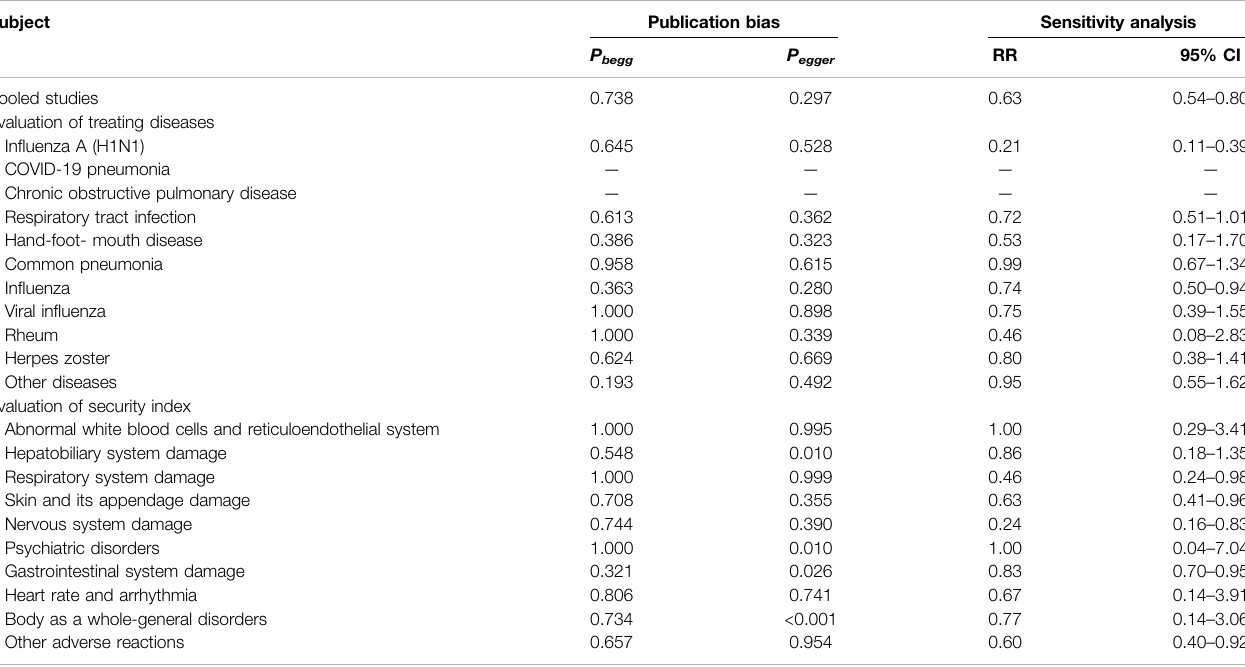
TABLE 2 | Results of publication bias and sensitivity analysis.